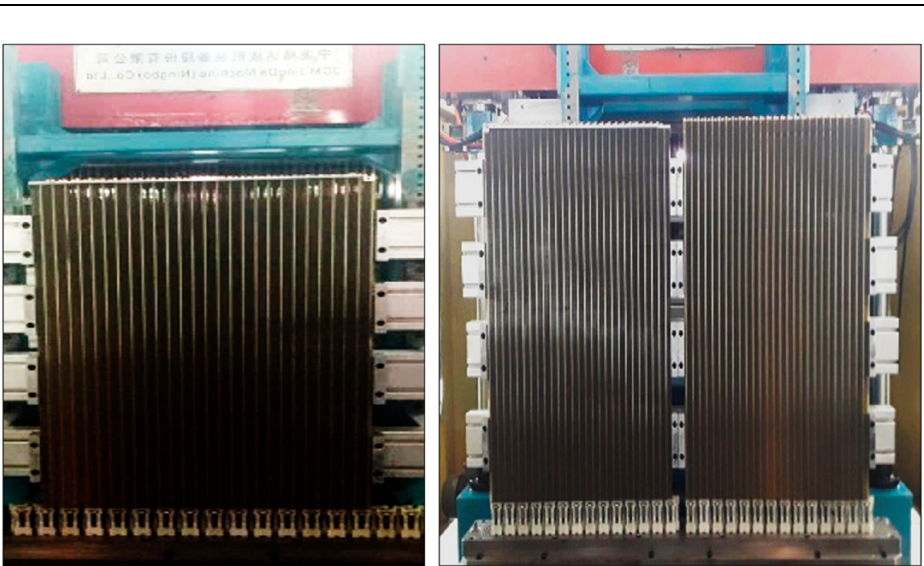
Figure 10. Before and after comparison of expanding machine.